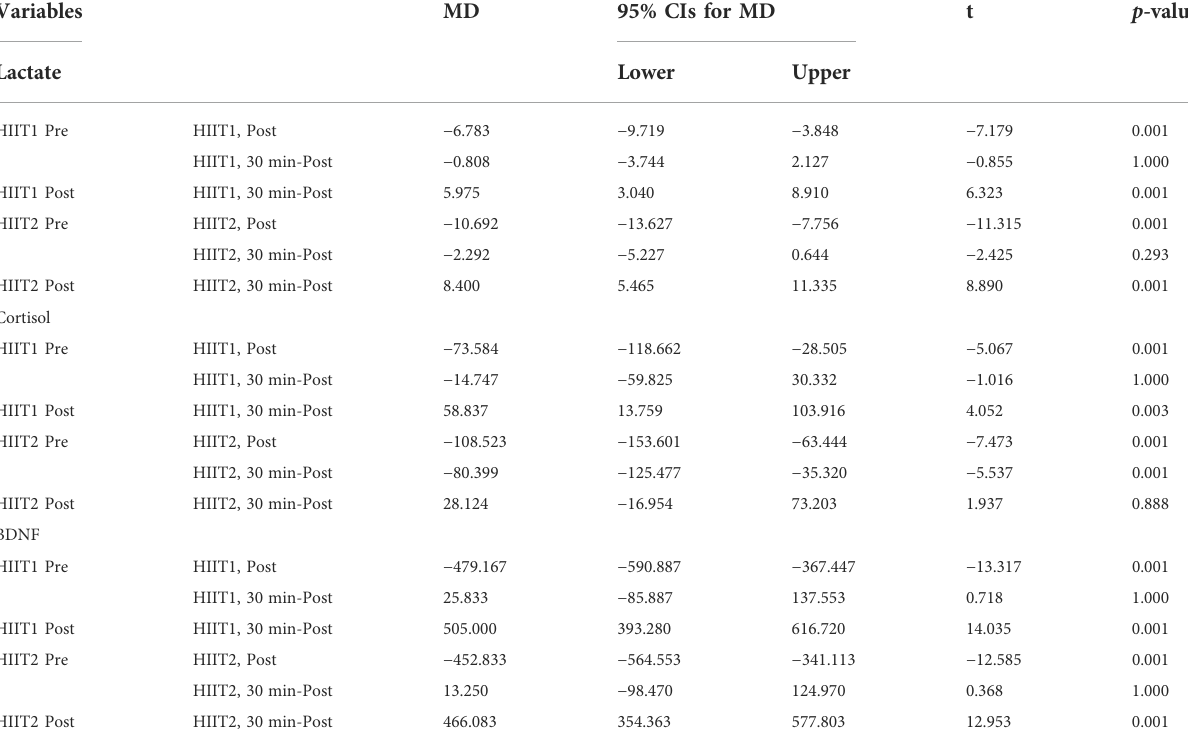
TABLE 3 Mean changes (95% con fi dence intervals, 95%CIs) from pre, post and 30-min post for Lactate, Cortisol and BDNF.